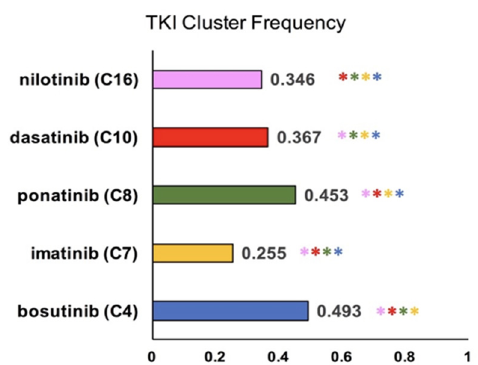
abstracts in the clusters pertaining to five TKIs: bosutinib (blue), imatinib (gold), ponatinib (green), dasatinib (red), and nilotinib (pink). ( B ) Output of the k-means clustering algorithm showing the most relevant abstracts and clusters.